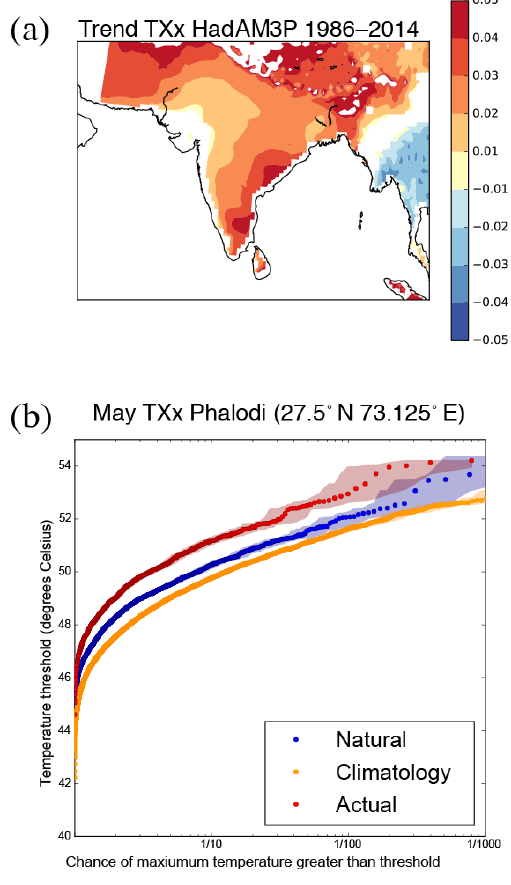
Figure 11. (a) HadAM3P model trend for 1986–2014 of TXx in May (Kyr − 1 ). Ocean points and areas not significant at p < 0.05 are shown as white. (b) Return time plots for TXx in May at the grid box closest to Phalodi for “actual” 2016 simulations (red), “nat- ural” 2016 simulations (blue) and Climatology 1986–2014 simula- tions